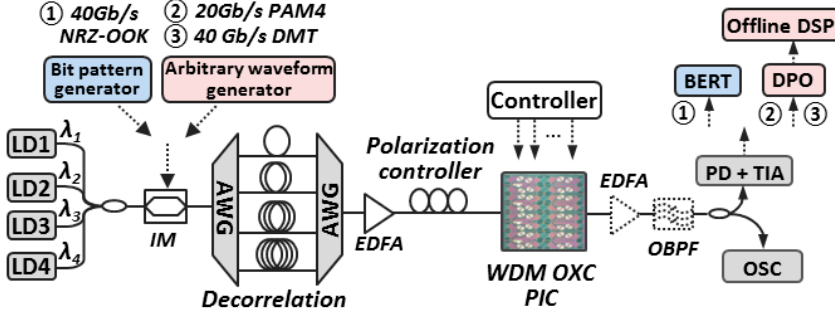
Figure 12. Experimental setup for the performance assessment of NRZ-OOK traffic.